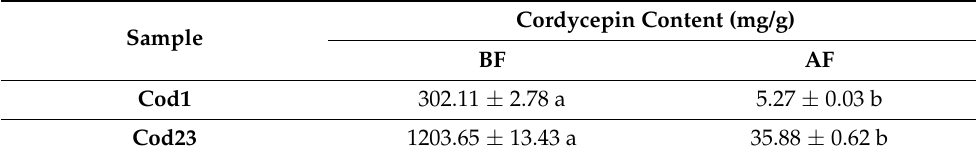
Table 4. Change of cordycepin quantity in samples after kombucha fermentation.